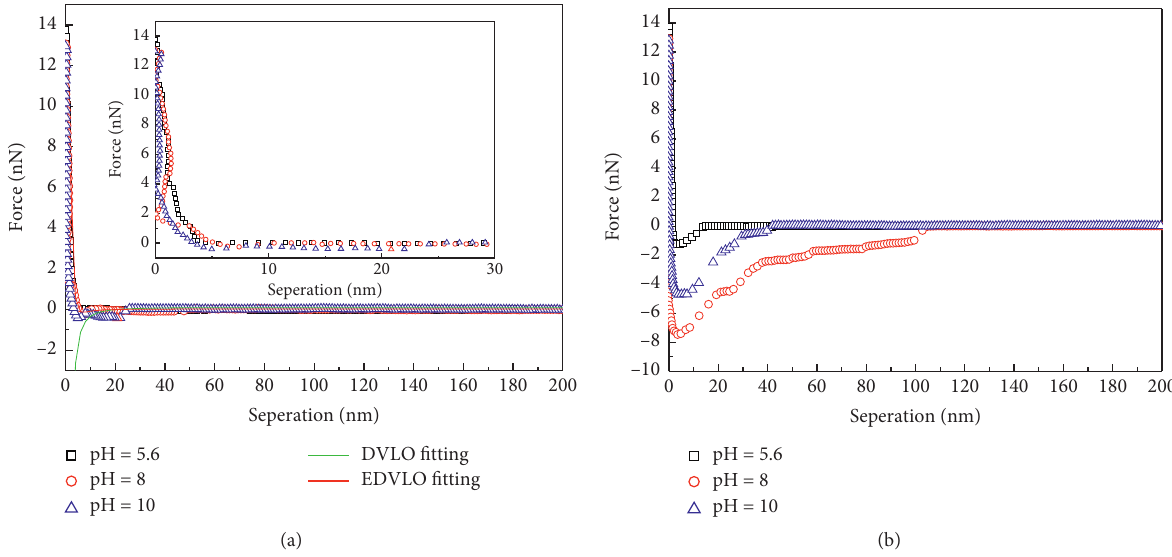
Figure 13: The interaction forces between scheelite particle and scheelite substrate in ultrapure water solution: (a) approach curves; (b) retraction curves.